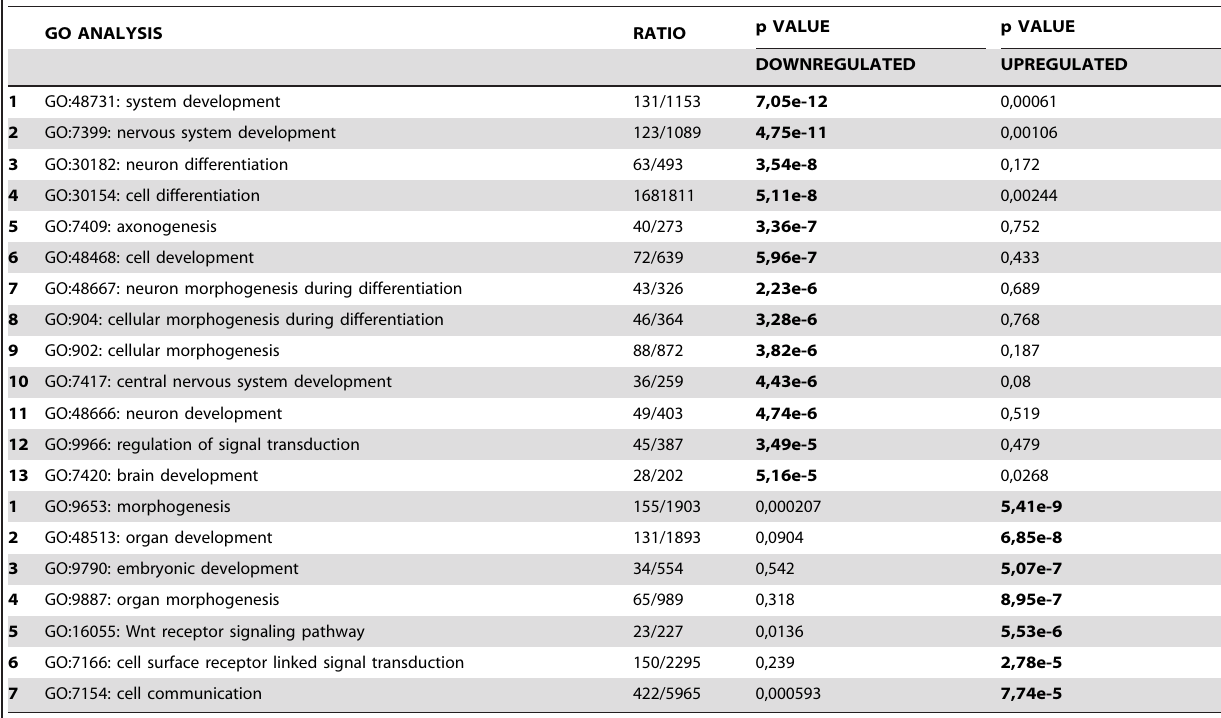
Table 1. Hoxb1-regulated biological